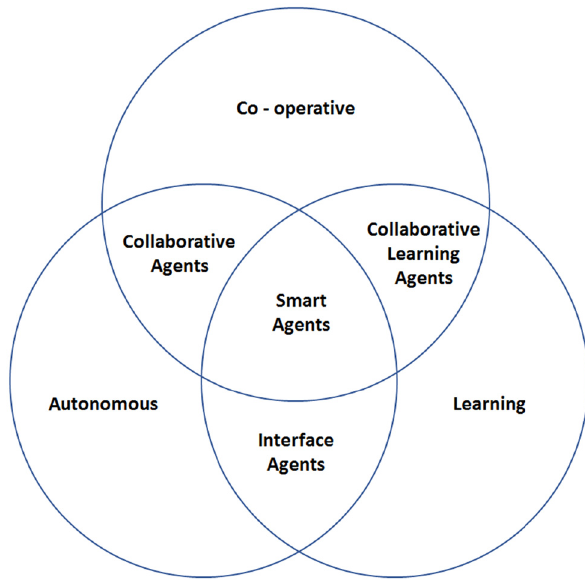
Figure 2: Three fundamental behavioural attribute categories. Each agent must possess at least two. Source: original work based on ref. [ 22 ]